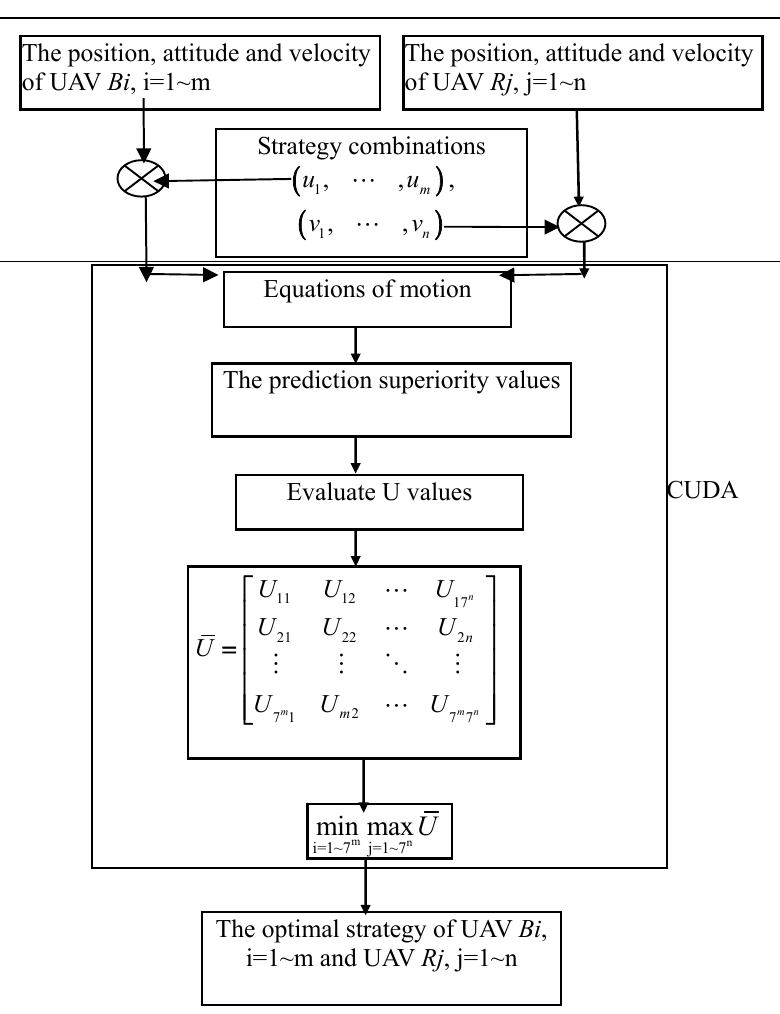
Figure 3. Flowchart of team negotiation